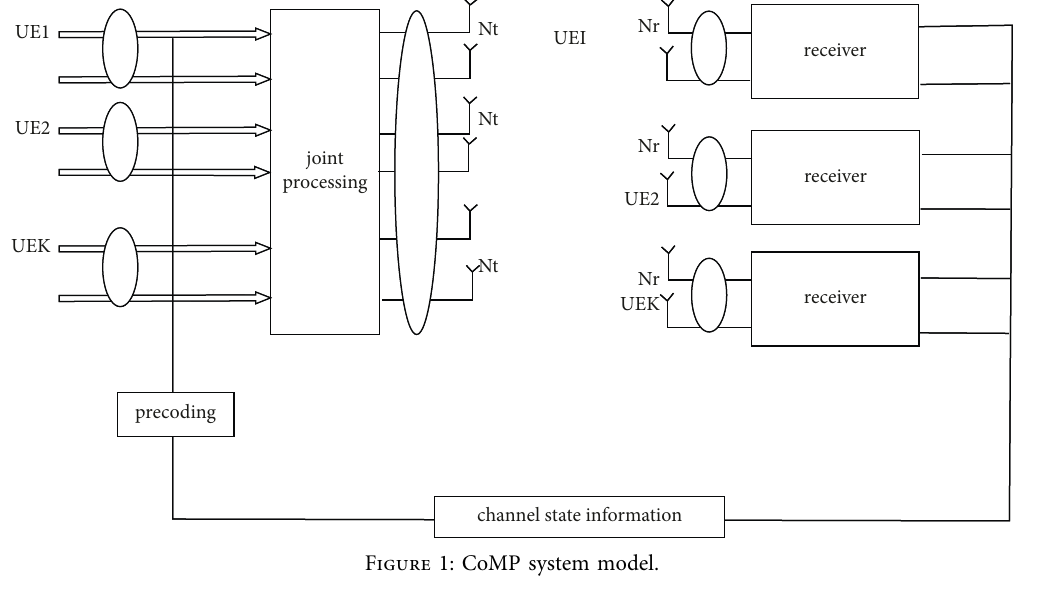
Figure 1: CoMP system model.